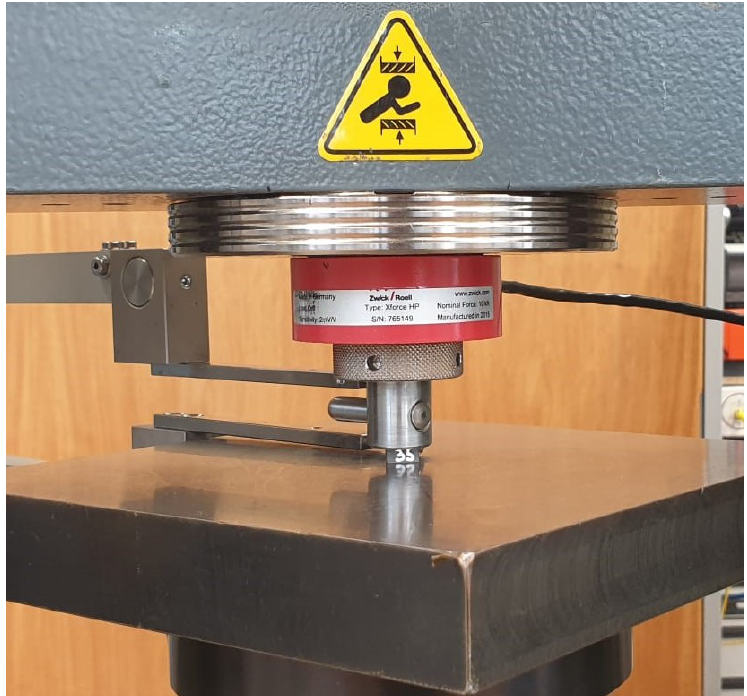
Figure 2. Experimental setup for compression test.